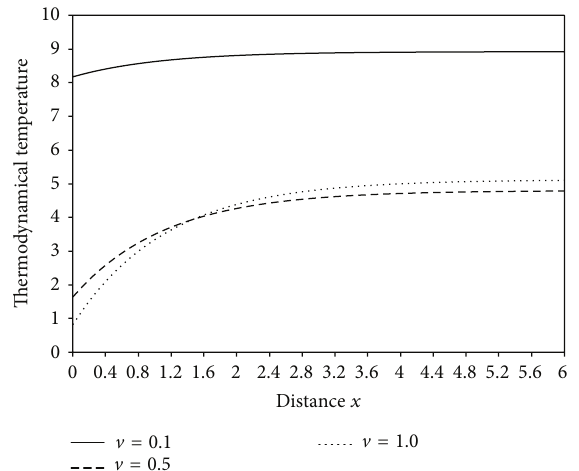
Figure 9: Effects of viscosity and two-temperature parameter on displacement distribution.